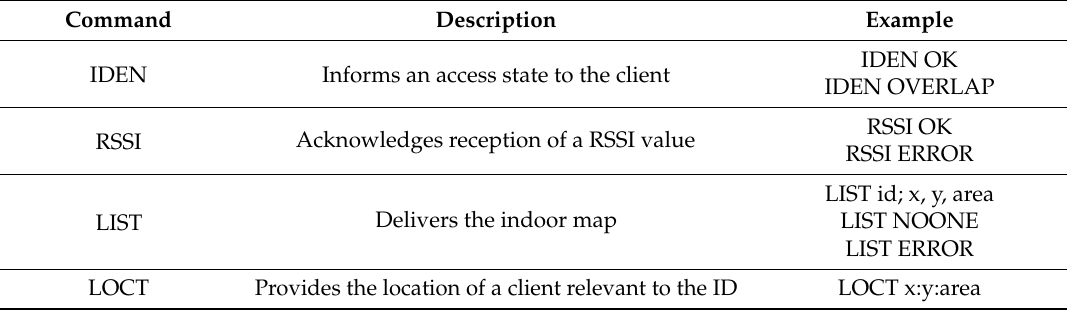
Table 3. Commands for